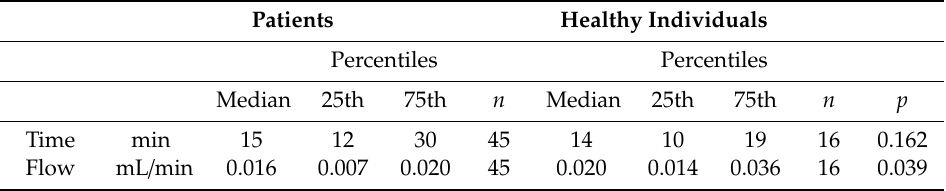
Table 2. Unstimulated parotid saliva sampling time and saliva flow rate in 45 patients with juvenile idiopathic arthritis and 16 healthy sex- and age-matched healthy individuals.